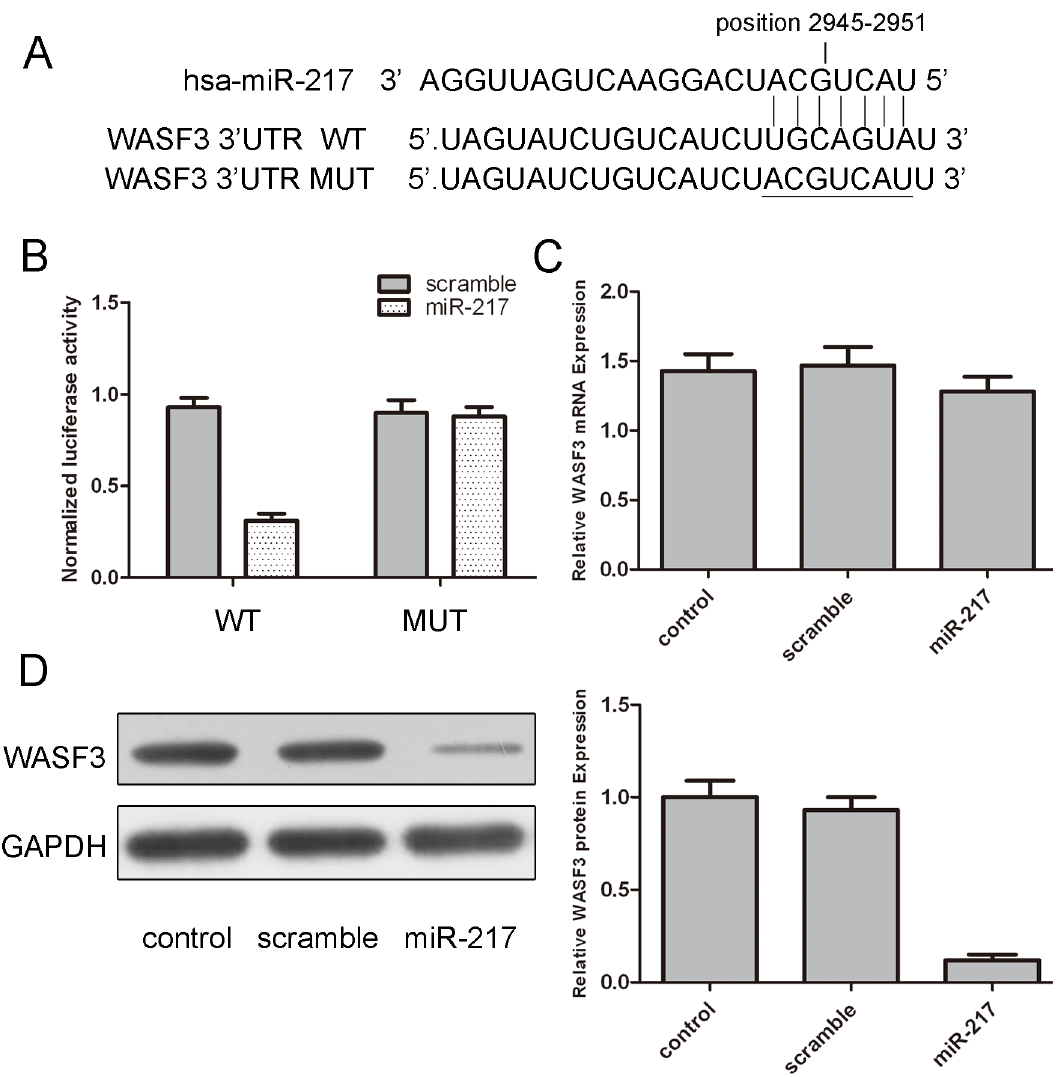
Figure 3. MiR-217 targets WASF3 in osteosarcoma cells. (A) The sequences of miR-217 binding sites within the human WASF3 3 9 UTR and schematic reporter constructs, in this panel, WASF3-WT represent the reporter constructs containing the entire 3 9 UTR sequences of WASF3. WASF3- MUT represent the reporter constructs containing mutated nucleotides. (B) The analysis of the relative luciferase activities of WASF3-WT, WASF3-MUT in 293T cells. The error bars are derived from triplicate expriments. (C) qRT-PCR analysis of WASF3 mRNA expression in MG-63 cells after treatment with miRNA mimics or scramble or no transfection. The expression of WASF3 was normalized to GAPDH. (D) Western blot analysis of WASF3 expression in MG-63 cells transfected with miR-217 mimics or scramble or no transfection. GAPDH was also detected as a loading control. All data uses t test and is shown as mean 6 SEM.